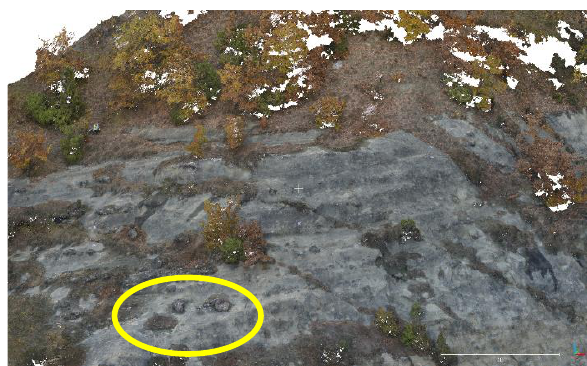
Figure 10. Original UAV point cloud displayed using the RGB channels; vegetation, moss and rock is clearly distinguishable. Near to the lower left corner are visible some of the rip-up clasts present on the surface.